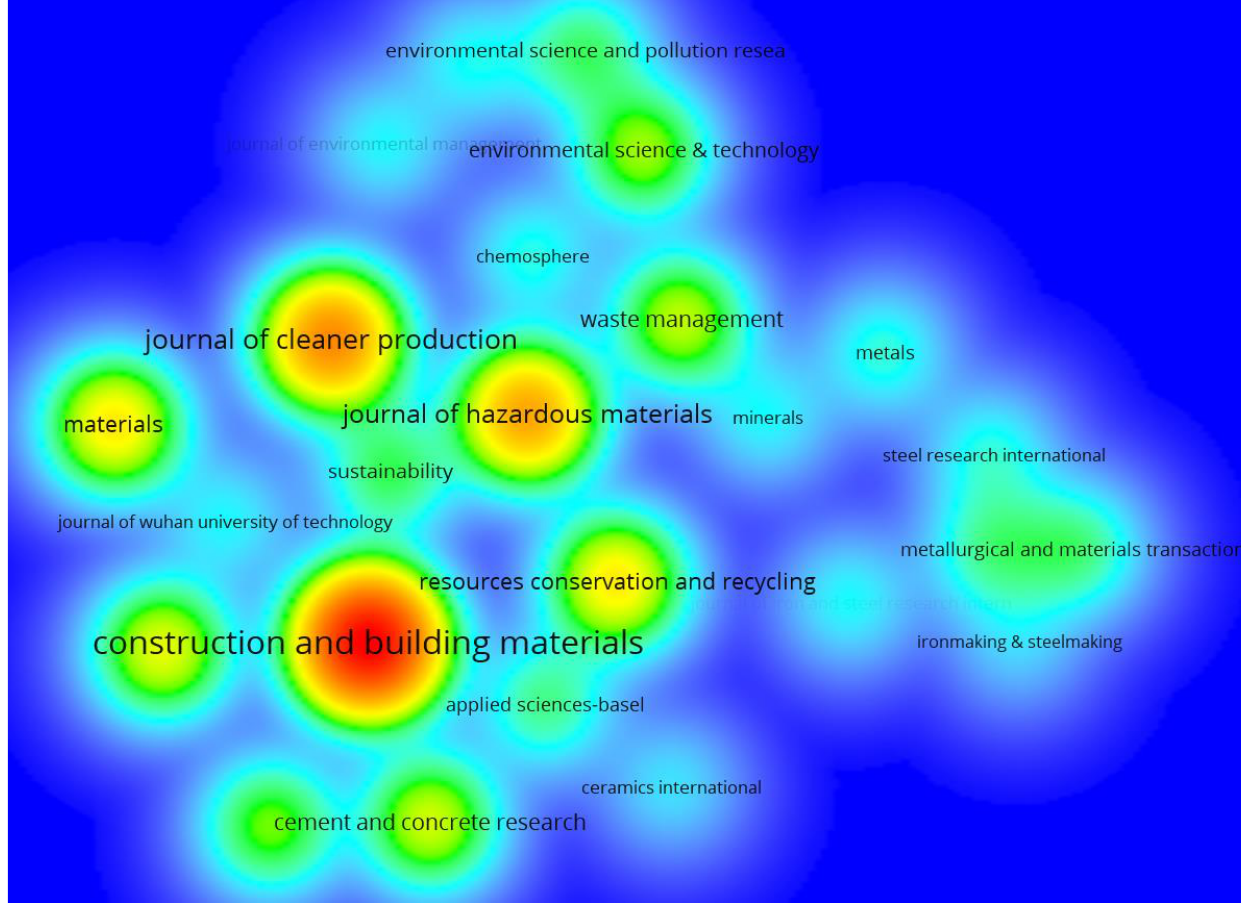
Figure 9. Citation density diagram of journals in the research field of steel slag.